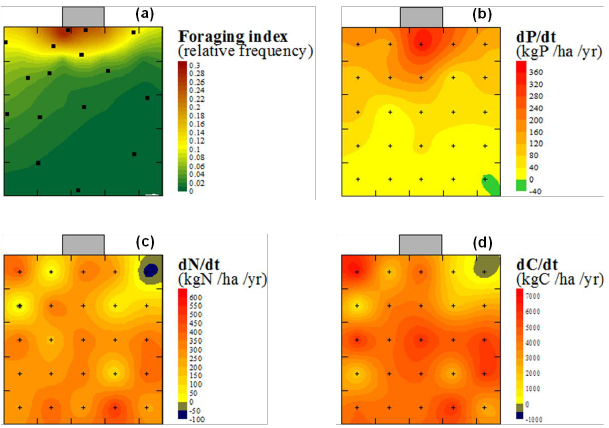
Fig. 6. Kriged maps of broiler foraging index (collective probability of broilers being present on a surface area of 1 m 2 at a given location) (a) and annual variations of phosphorus (b) , total nitrogen (c) and total carbon (d) soil stocks. Black squares (a) indicate locations for chamber measurements, while crosses (b, c, d) indicate soil sampling sites.